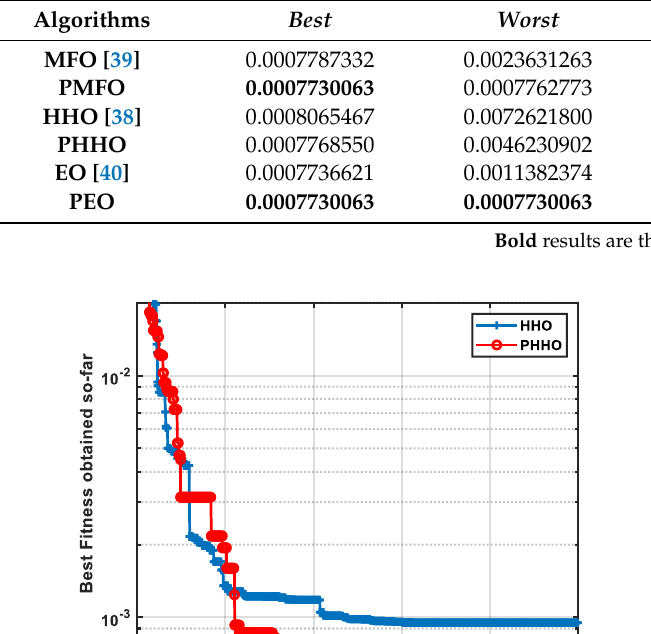
Table 4. Comparison of statistical measures of RTC France.